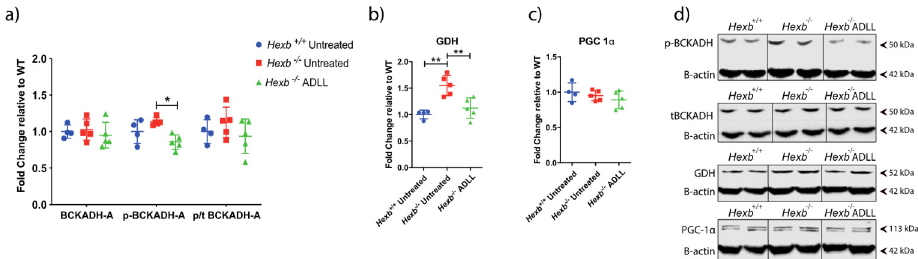
Figure 3. Effects of acetyl-DL-leucine on BCAA and glutamate and energy metabolism in